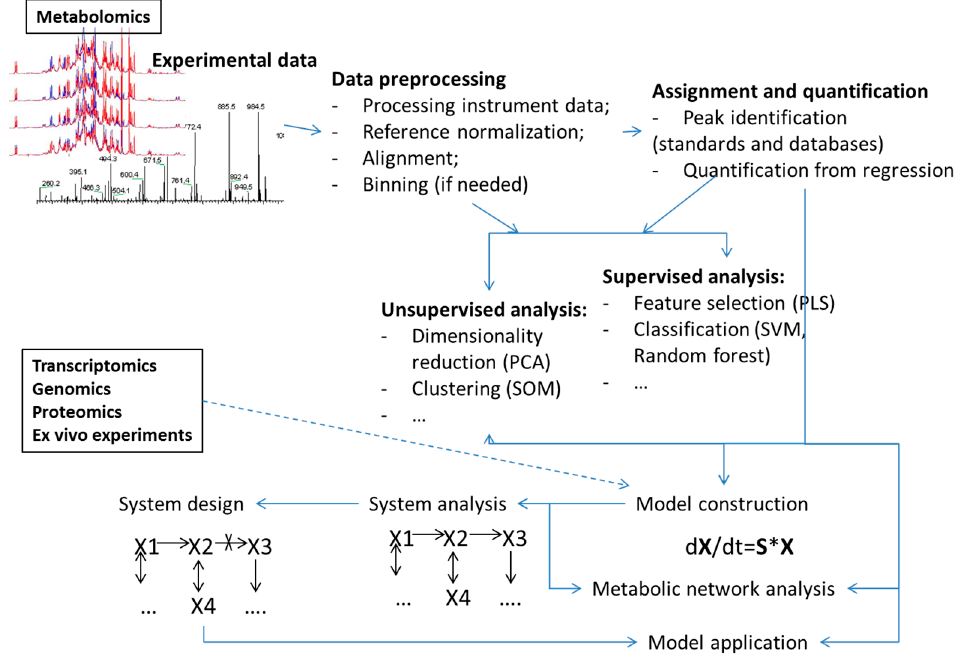
Figure 1. Overview of different data analysis steps in metabolomics and metabolism modeling where machine learning methodologies have found uses.